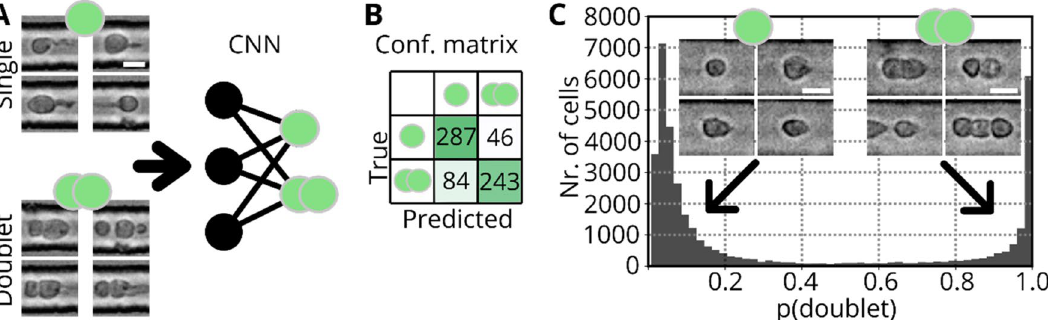
Figure 2. CNN for detection of cell aggregates. ( A ) Bright-field images of single cells and cell aggregates of human retinal organoid cells. Images are used to train a CNN for discrimination between single cells and cell aggregates. ( B ) Confusion matrix resulting when applying the CNN on the validation set. The validation accuracy is 80.3%. ( C ) Probability distribution resulting when applying the model to a testing dataset